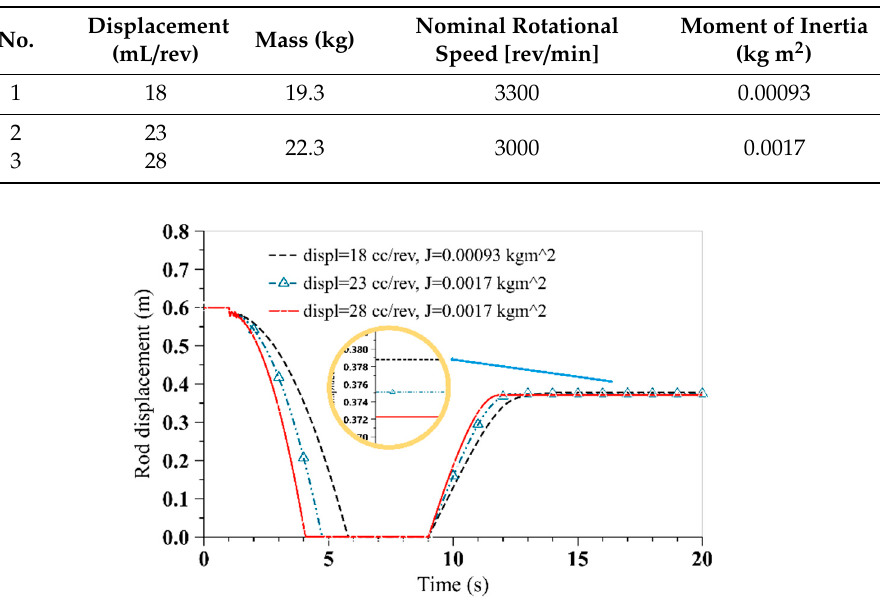
Energies 2020 , 13 , x FOR PEER REVIEW Figure 21. Displacements of the boom cylinder at di ff erent PM displacements. Figure 21. Displacements of the boom cylinder at different PM displacements.